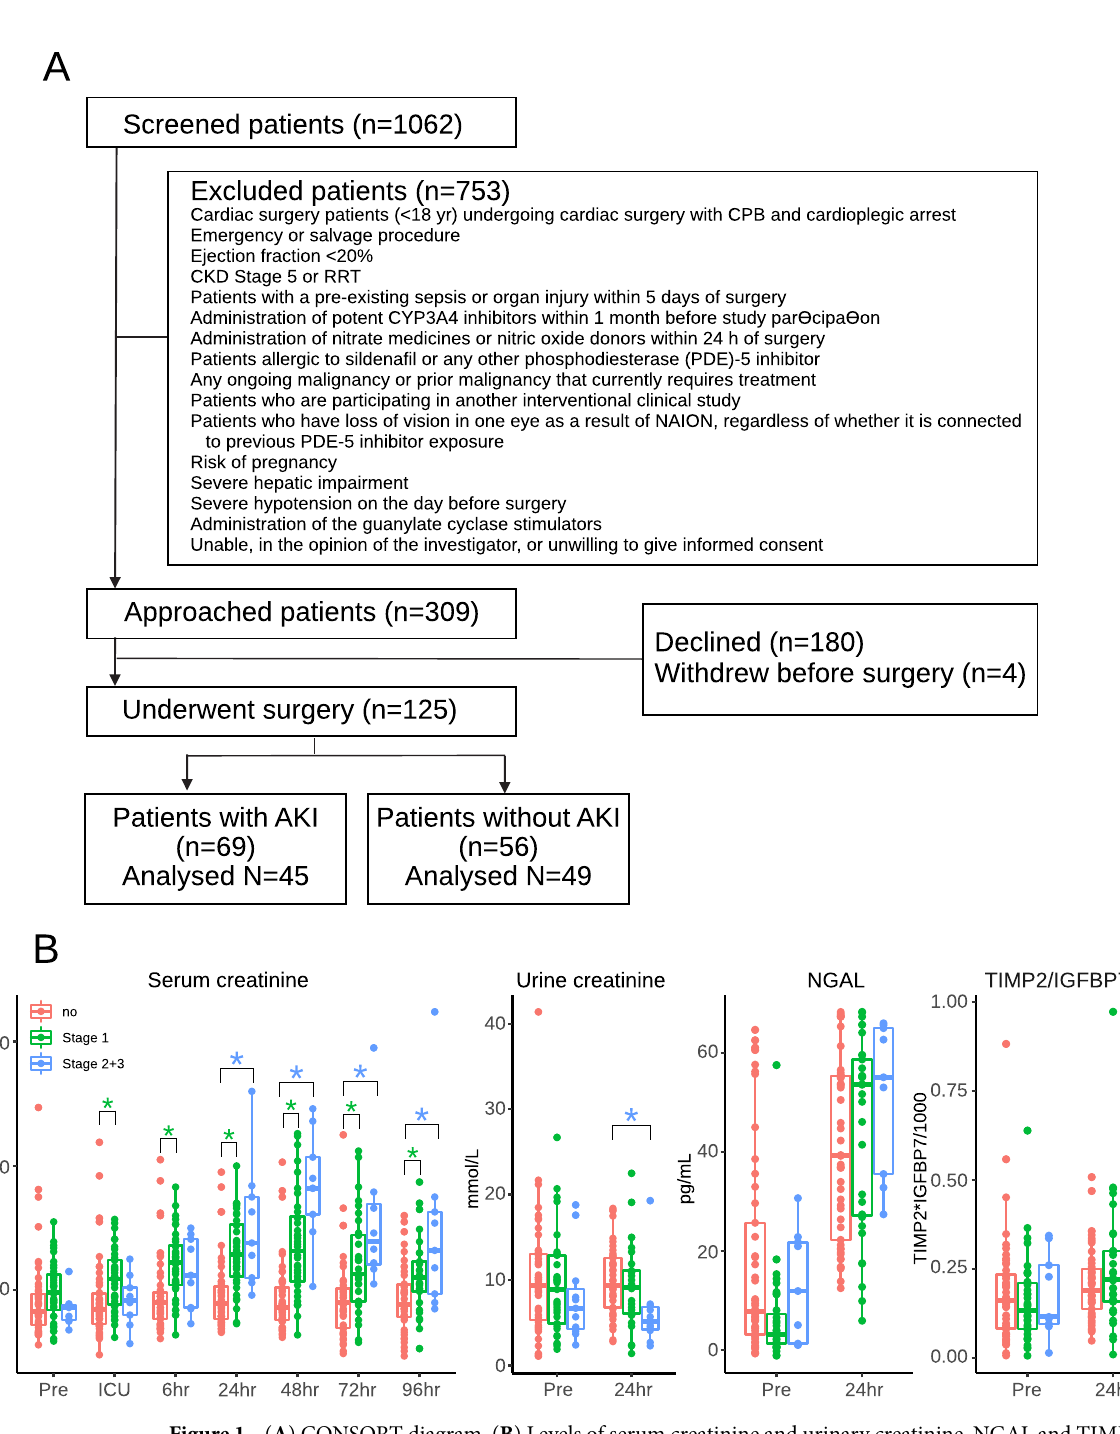
Figure 1. ( A ) CONSORT diagram. ( B ) Levels of serum creatinine and urinary creatinine, NGAL and TIMP2/ IGFBP7. Green asterisks indicate a significant difference ( p < 0.05) between no-AKI and AKI stage 1; blue asterisks indicate a significant difference between no-AKI and AKI stage